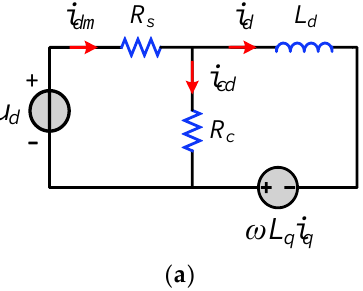
Figure 4. PMSM equivalent circuit considering the ferromagnetic loss: ( a ) d-axis circuit; ( b ) q-axis circuit.